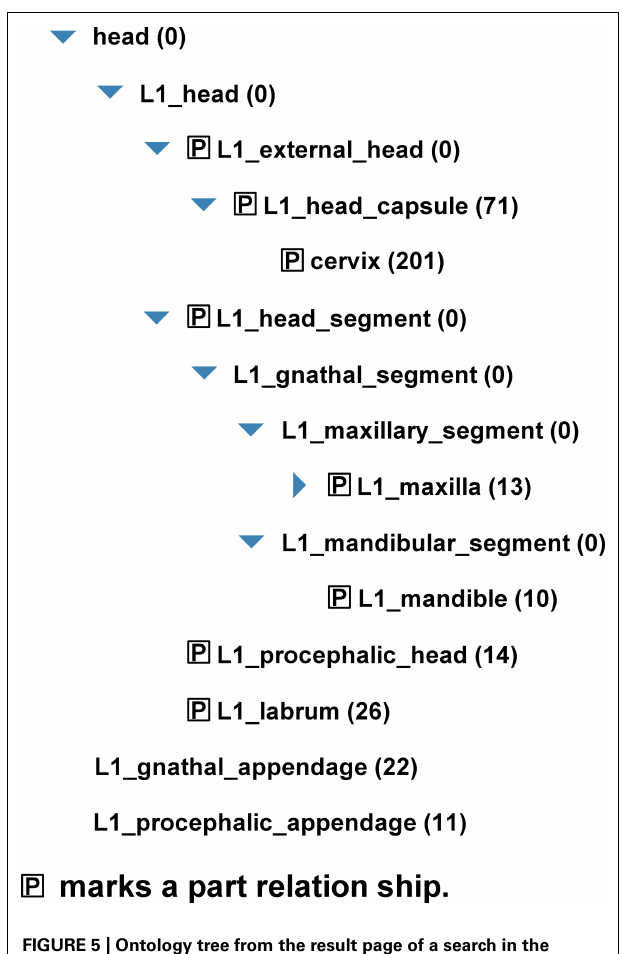
FIGURE 5 | Ontology tree from the result page of a search in the iBeetle database. The tree shows the classes of the Tribolium ontology downstream of the searched structure and linked to the queried developmental stage. In this example, the user has selected “head” as anatomical structure and “larva” as stage. All ontology classes shown in the tree where used for a search in the iBeetle database.The numbers in parentheses indicate the number of hits linked to this